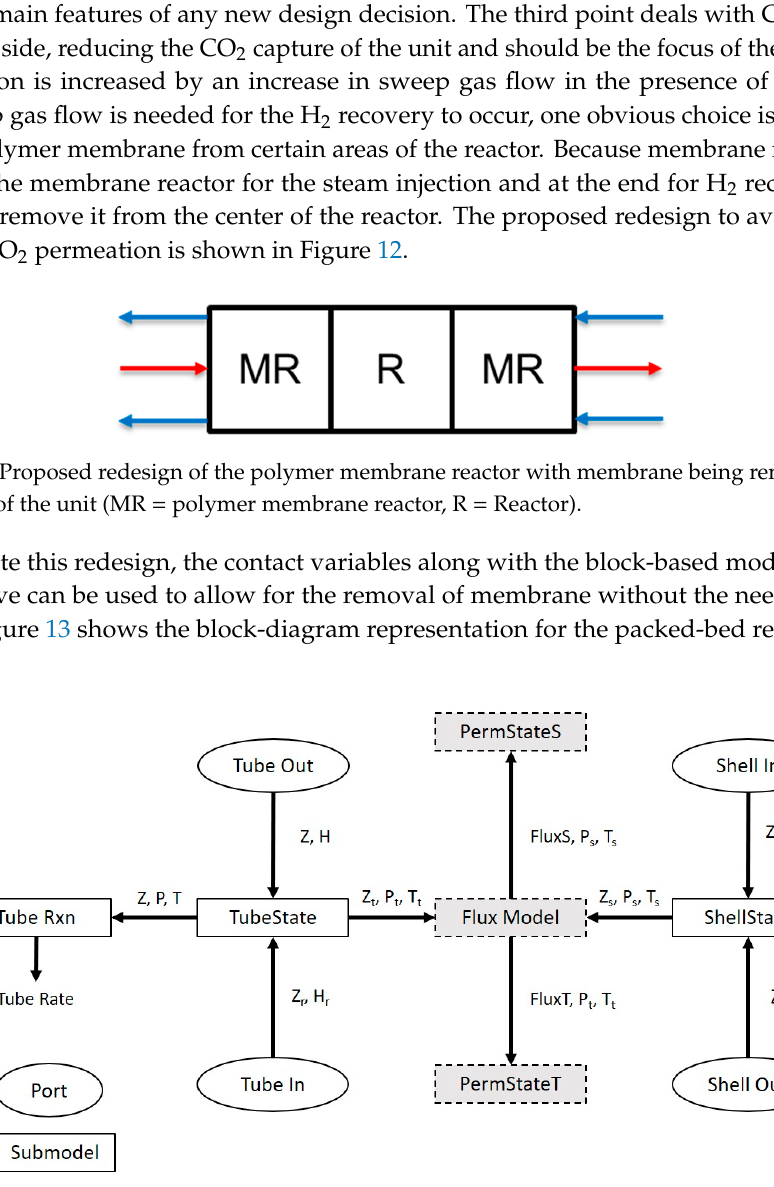
Figure 13. Diagram representing how removal of the Flux, PermStateT, and PermStateS submodels leads to the MemElem model of a packed-bed reactor. leads to the MemElem model of a packed-bed